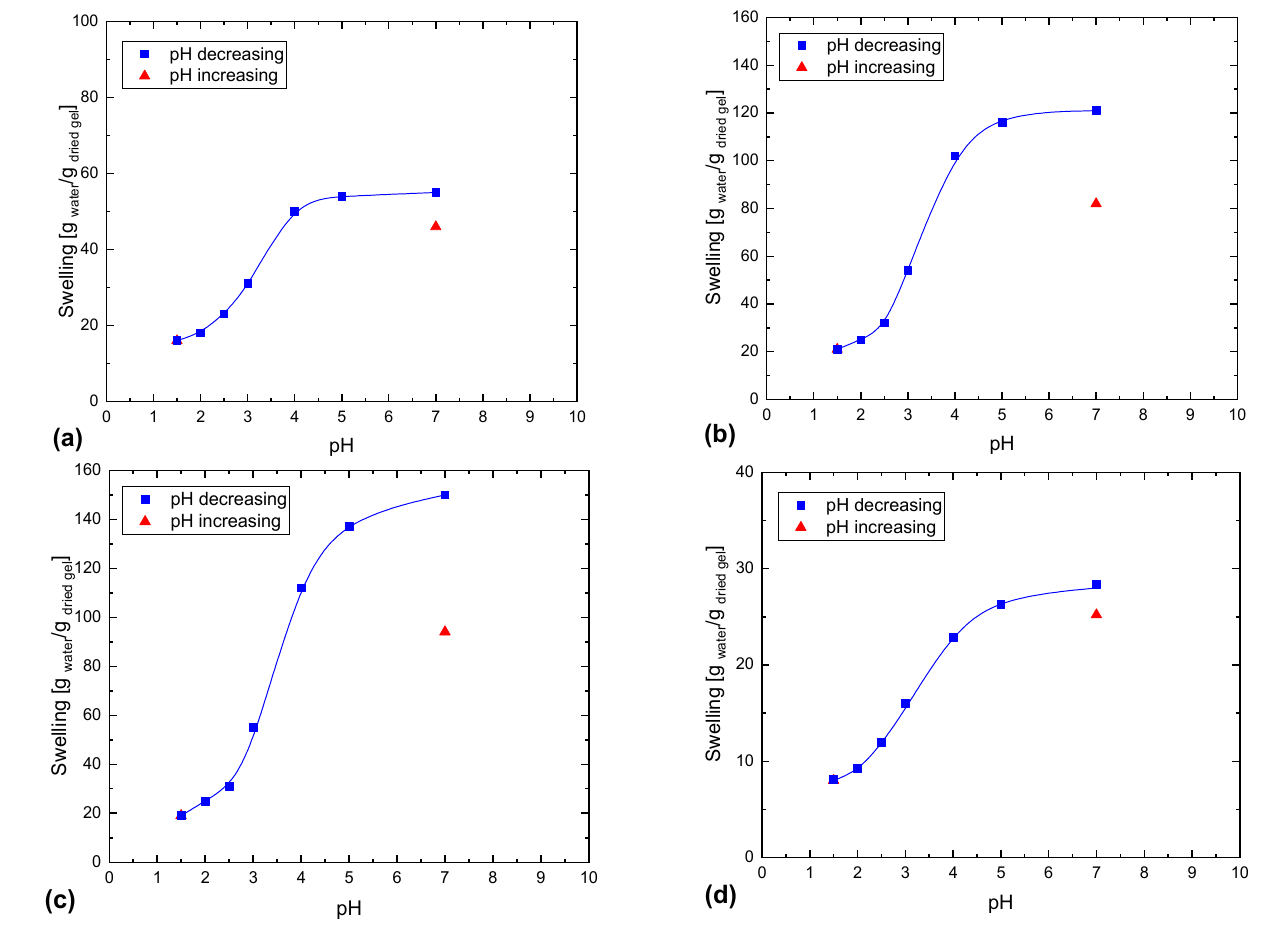
Figure 9. pH-dependent swelling of CMC hydrogels formed with 25 kGy in the presence of PEGDA; CMC%/PEGDA% content: ( a ) 2.5/2.5, ( b ) 5/2.5, ( c ) 10/2.5, and ( d ) 2.5/5.